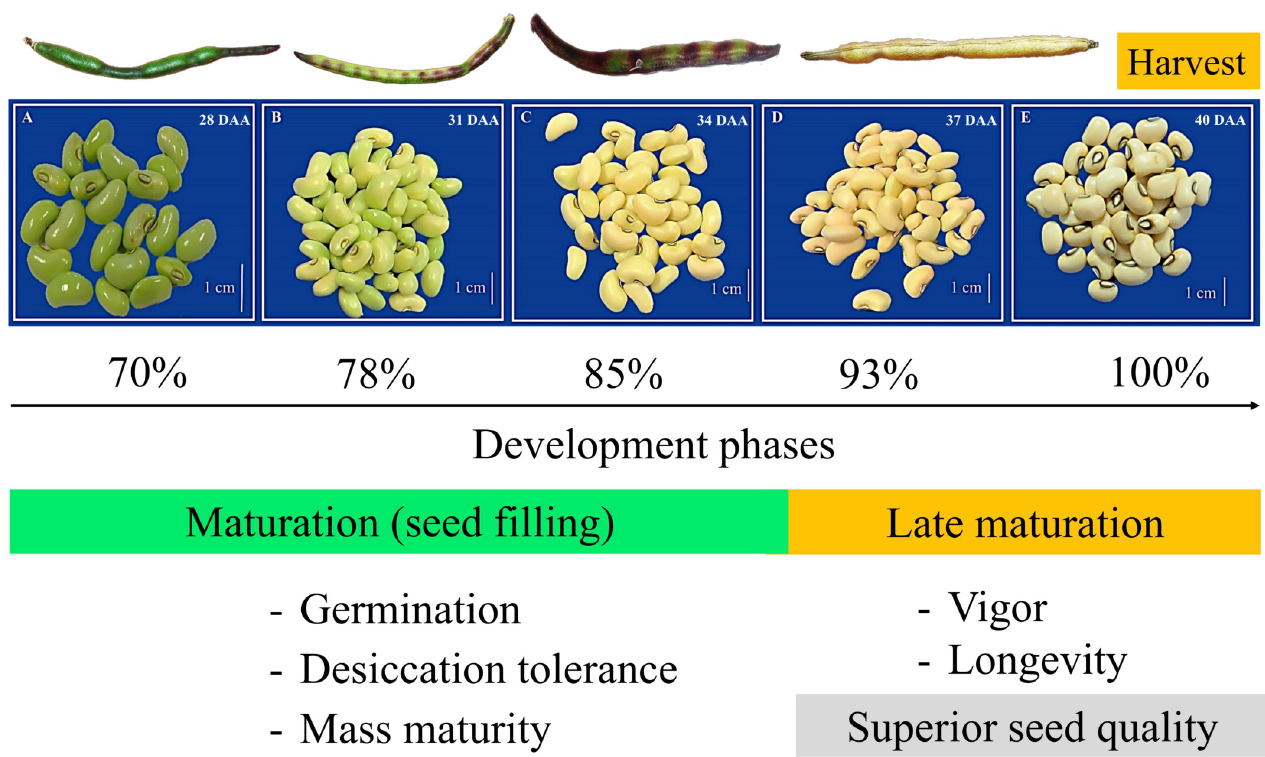
Fig 4. Phases of cowpea seed development. The relation between the developing stages and the acquisition of seed physiological quality during maturation and late maturation.